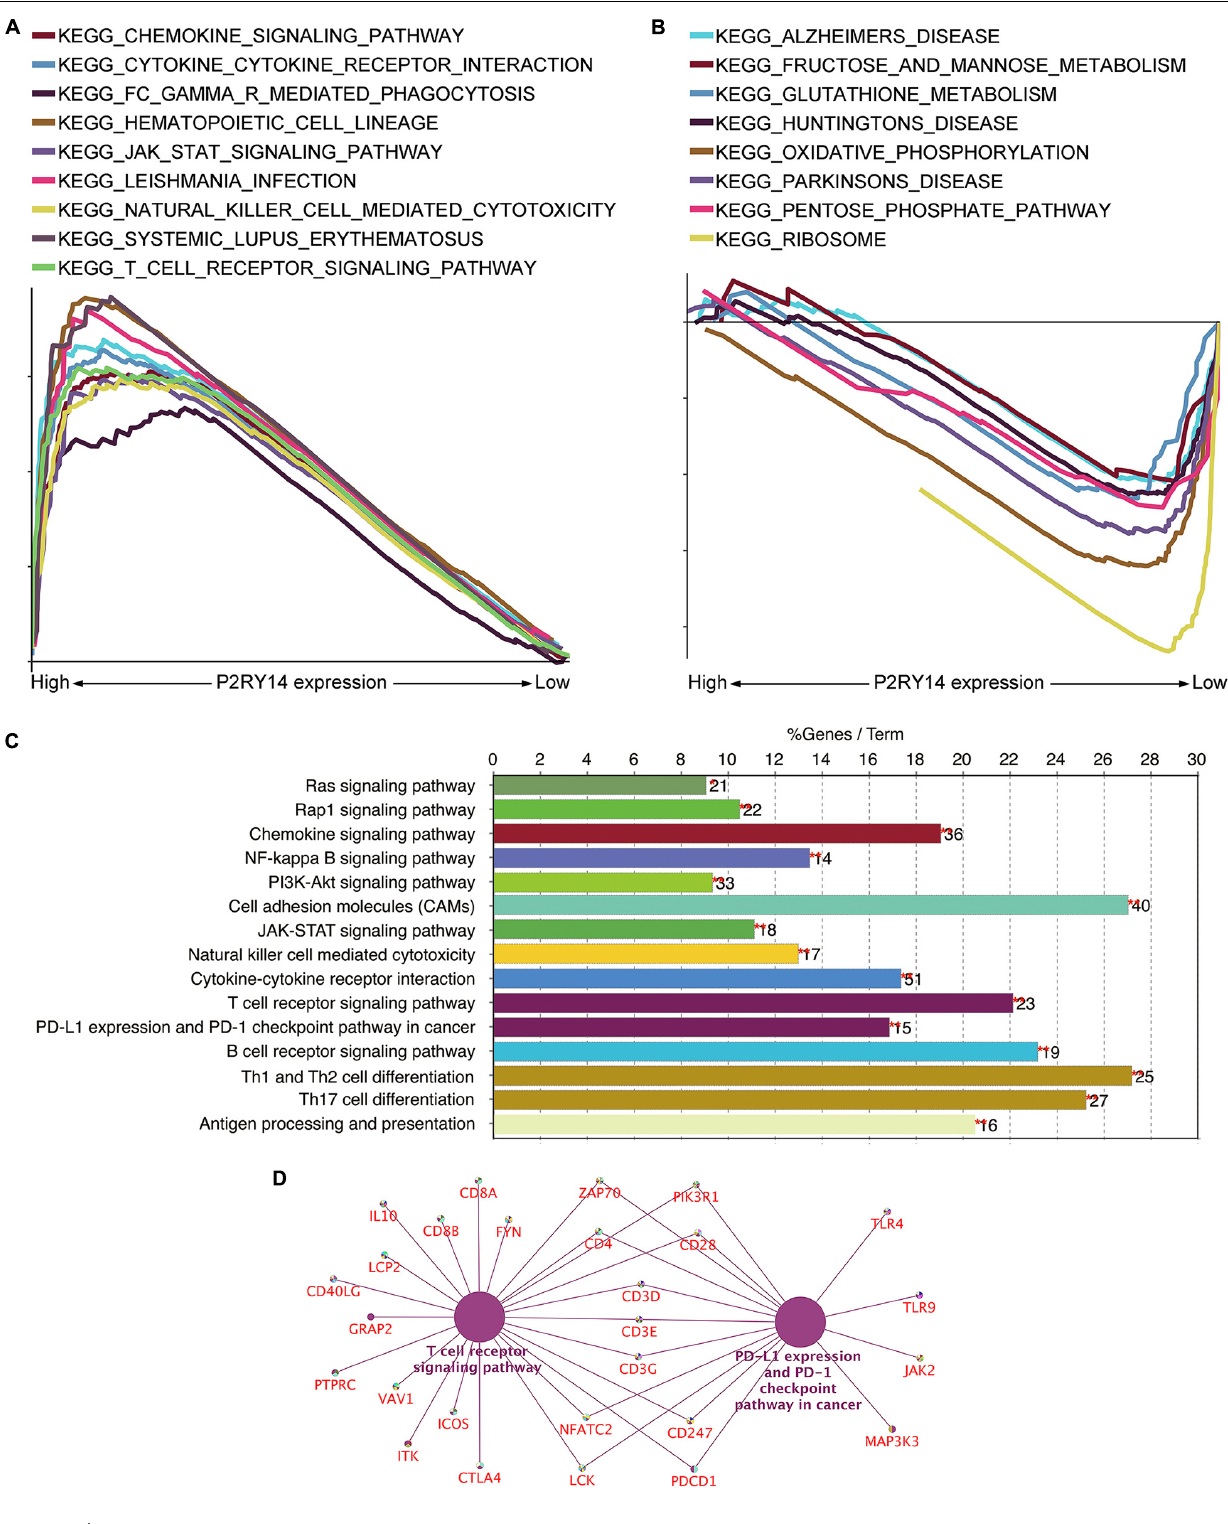
FIGURE 7 | Analyses of the functional role of P2RY14 gene in the tumor microenvironment (TME) and the underlying regulatory genes in HNSC. (A,B) The enriched gene sets in HALLMARK by the samples with high or low P2RY14 expression. (C) KEGG pathway analysis of the genes co-expressed with P2RY14. (D) The genes co-expressed with P2RY14 in the T-cell receptor signaling pathway and PD-L1 expression and PD-1 checkpoint pathway in cancer.